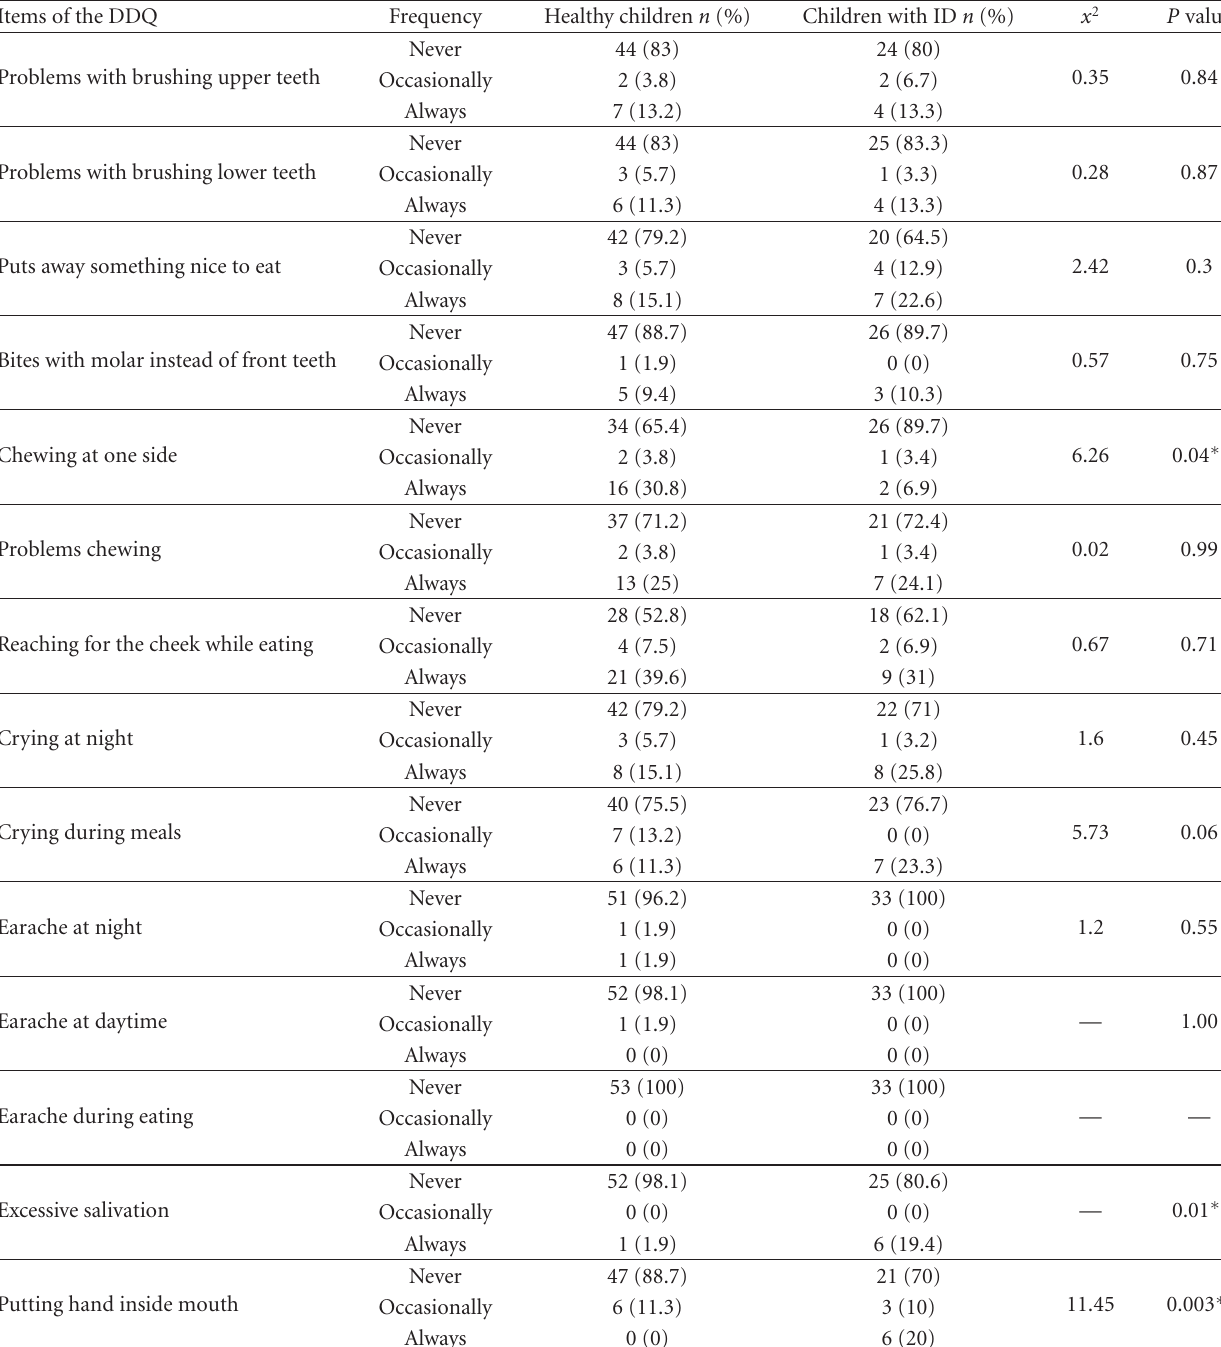
Table 3: Comparison of DDQ items between healthy children and children with ID in groups with dental